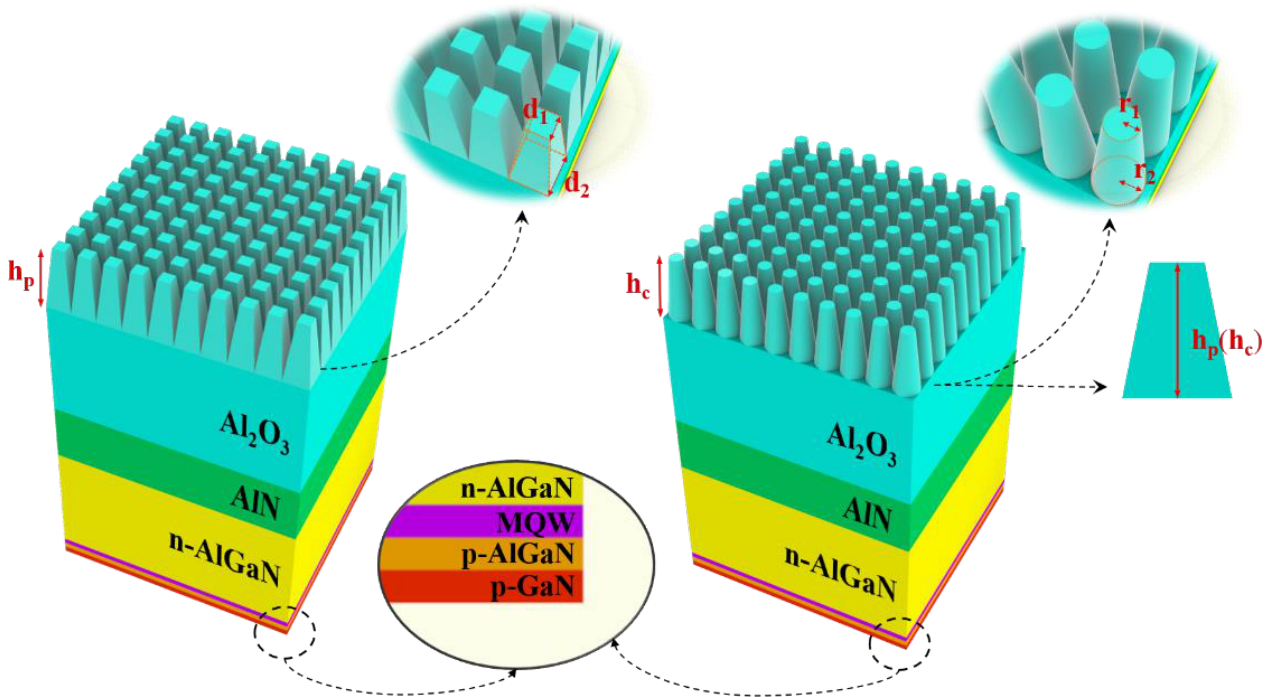
Figure 1. Perspective view of truncated-pyramid surface and truncated-cone surface DUV-LEDs.